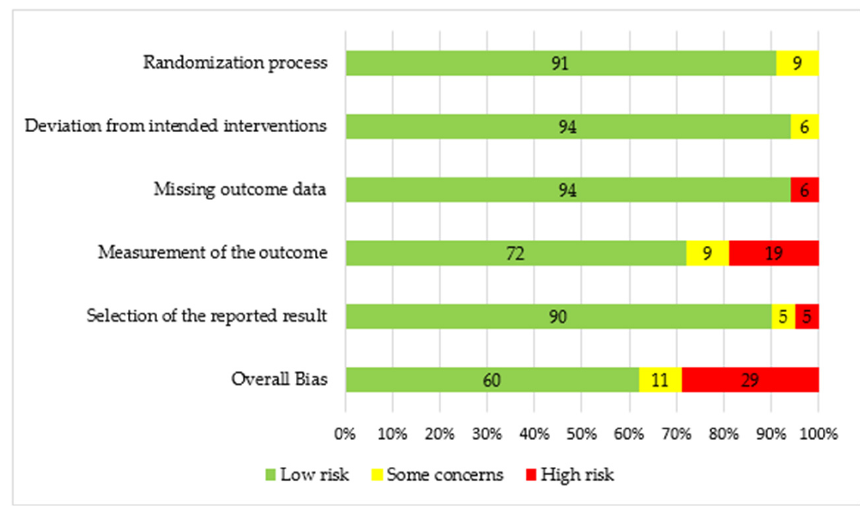
Figure A1. RoB analysis ( n = 55). Low risk studies: [16,19–33,35–37,39–43,45–53], some concerns